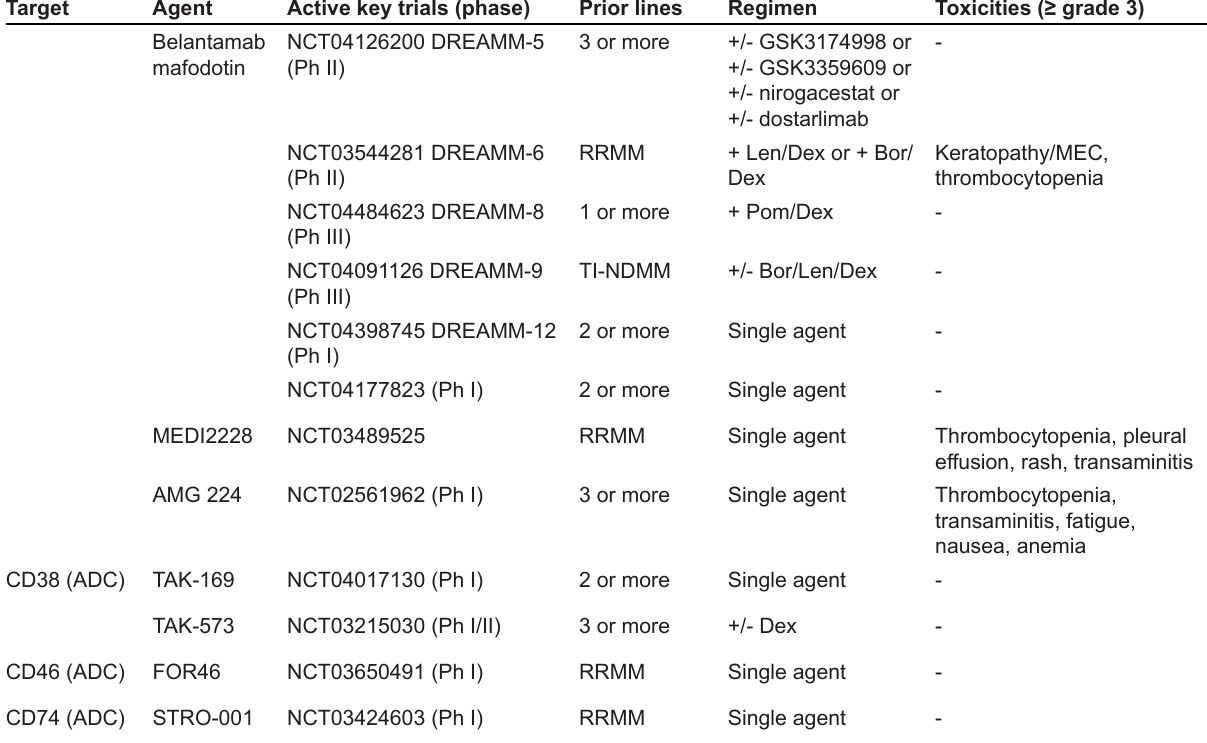
Table 1. ADCs in MM ( continued